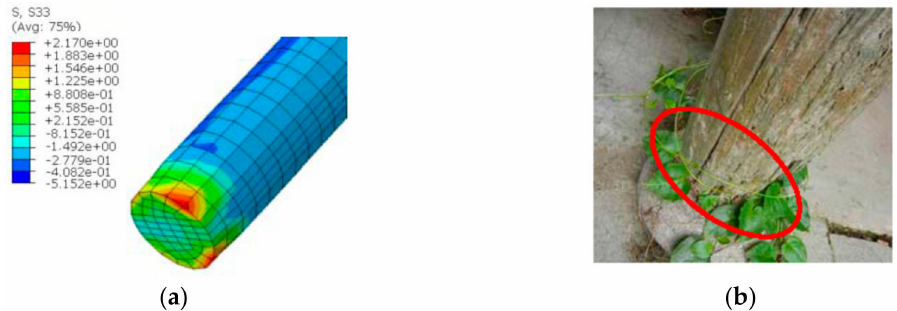
Figure 15. A column foot of the lounge: ( a ) Transverse grain stress contour plot of the column foot; ( b ) Site corroded column